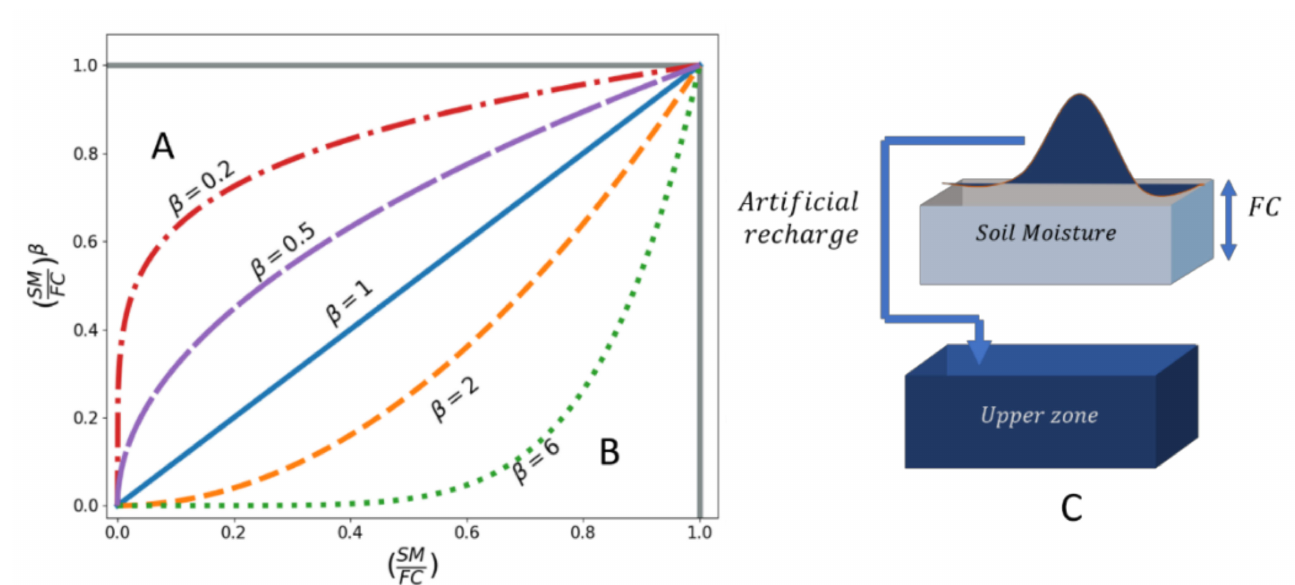
Figure 3. Elements of the HBV Structure: ( A ) Convex soil storage behavior (beta less than 1—model structure-2), ( B ) Concave soil storage behavior (beta more than 1—model structure-1), ( C ) Artificial recharge (model